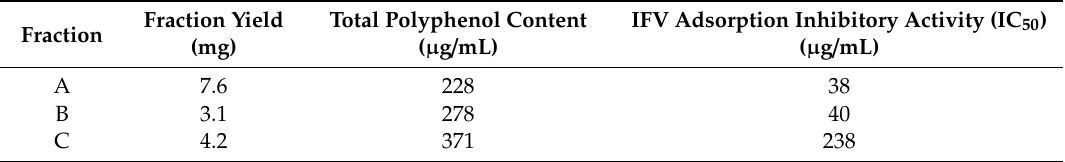
Table 2. Separation of Vaccinium oldhamii by HPLC. IFV—influenza virus.